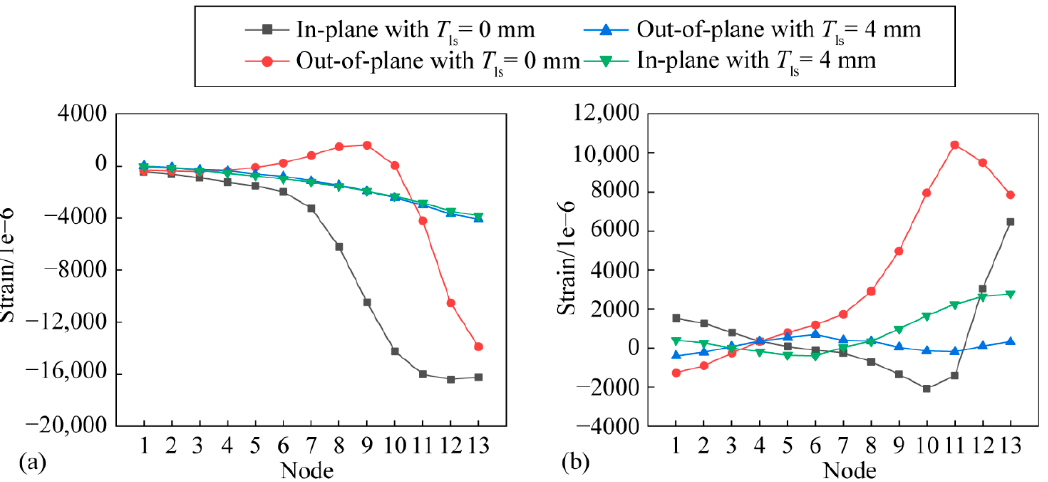
Figure 12. ( a ) Axial and ( b ) tangential strains in the top flange of the curved zone under ultimate capacity.